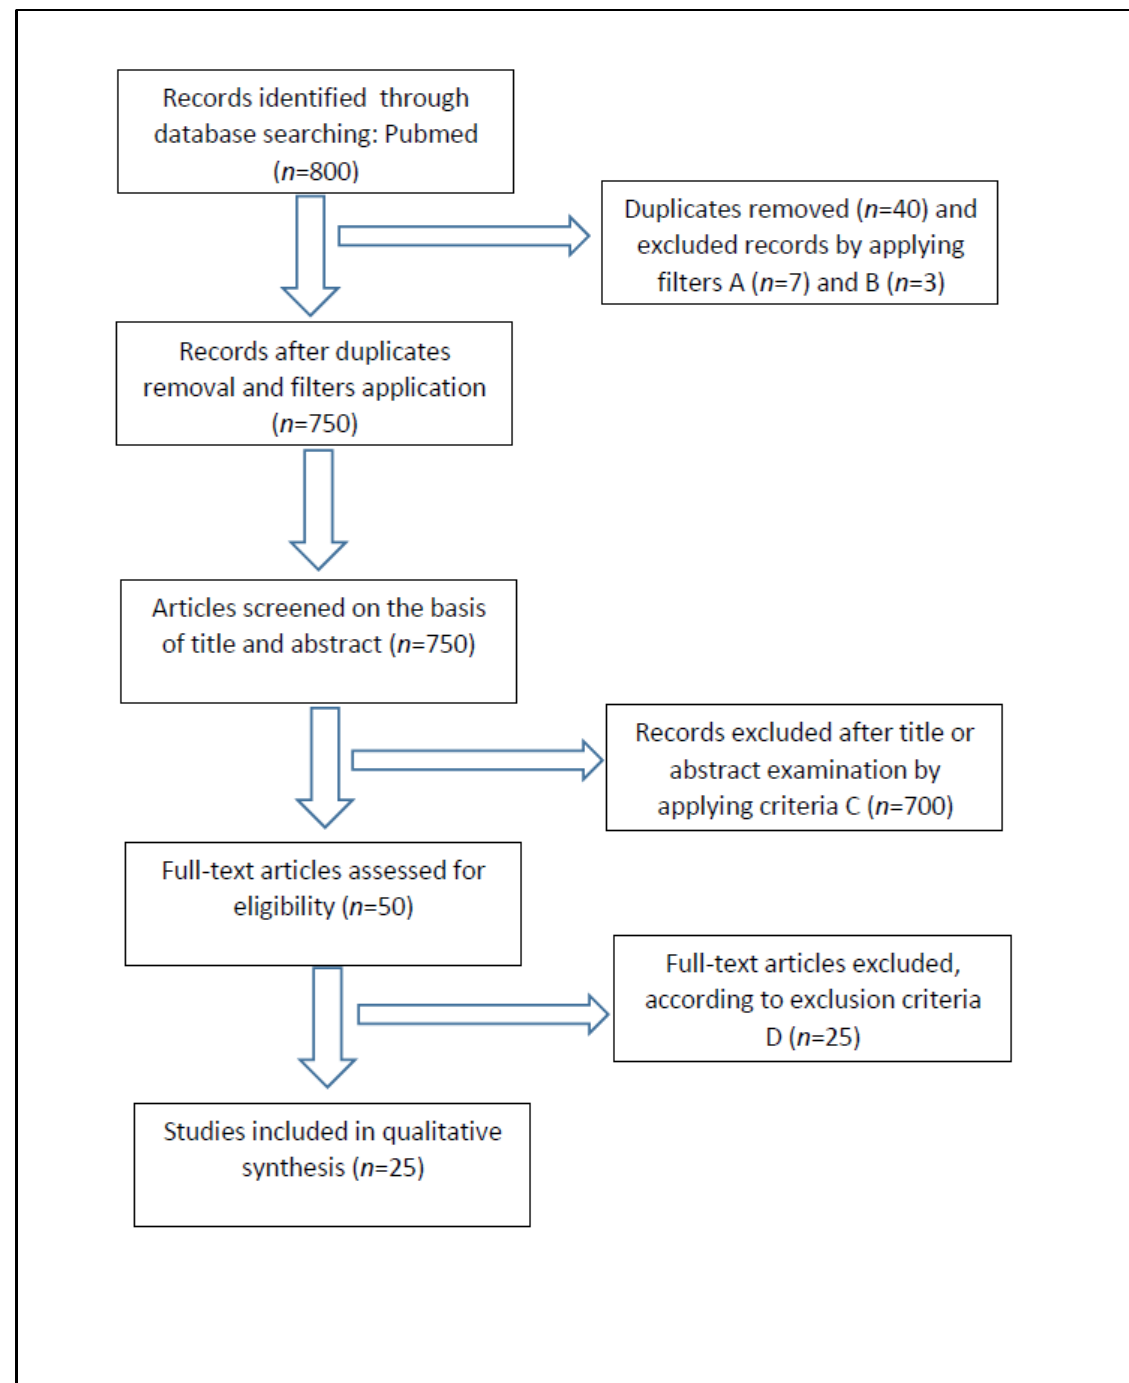
Figure 1. PRISMA 2020 flow diagram for new systematic reviews which included searches of databases and registers only.